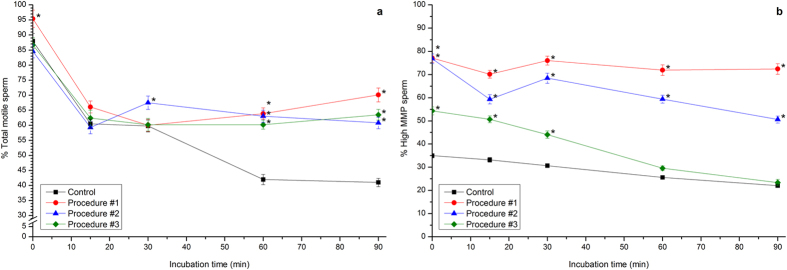
Percentages of total motility and high MMP spermatozoa of boar sperm cells subjected to incubation at 37 °C for 90 min after photo-stimulation procedures.Boar sperm were subjected to separate photo-stimulation procedures and subsequent incubation at 37 °C as described in the Methods section. At the indicated times, aliquots were taken and percentages of total motility (a) and high MMP sperm (b) were determined. Results are shown as mean ± SEM for 12 separate experiments. Asterisks indicate significant (P < 0.05) differences when compared with the respective Control value at the same time point.